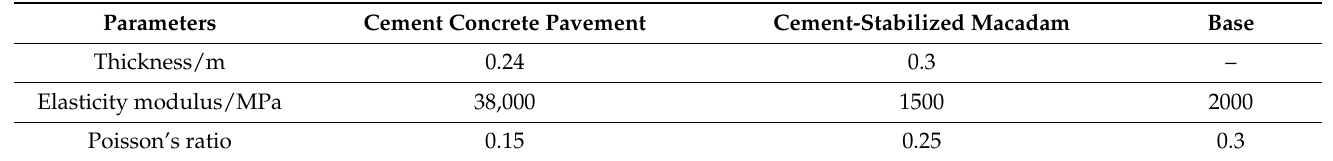
Figure 4. Schematic diagram of the aircraft load pavement slab and quarter aircraft wheel load vibration model. Schematic diagram of finite element meshing model of pavement slab structure. Table 3. Parameters of the pavement structure layer.